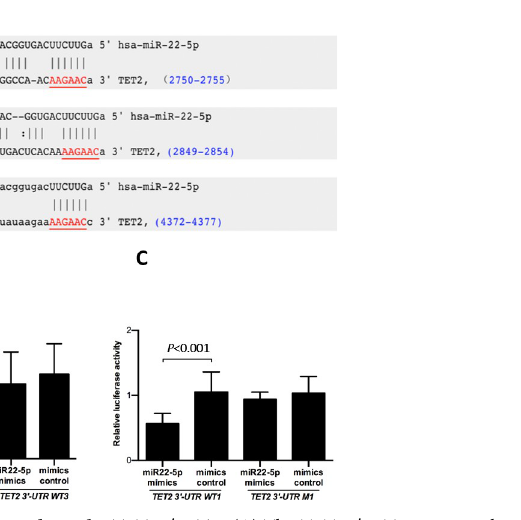
Fig 4. MiR22-5p directly regulates the TET2 3 0 -UTR. (A) The TET2 3 0 -UTR contains three possible miR22-5p- binding sites. The possible TET2-binding sites are indicated in red. (B) Relative luciferase activity for the three possible WT binding sites (n = 3). (C) Luciferase activity for TET2 3 0 -UTR WT1 and M1 (n = 3). Data were analyzed by Student’s t -test.